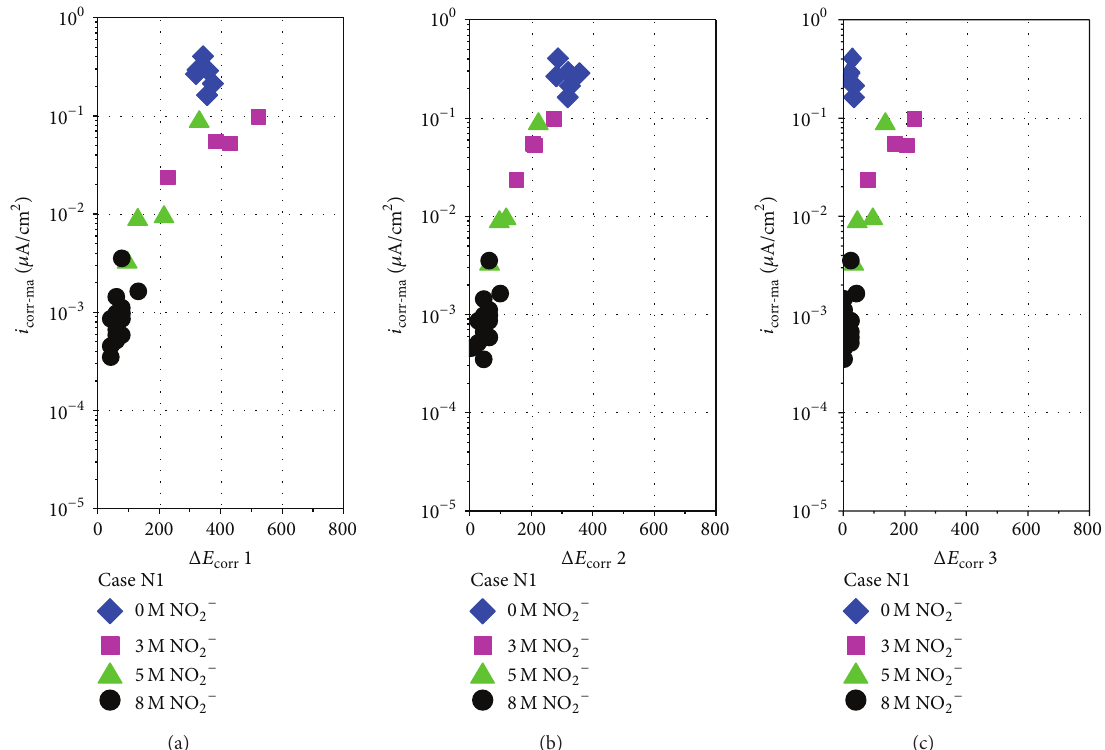
Figure 5: Effect of nitrite concentrations on the (a) relationships between Δ𝐸 Δ𝐸 2 and macrocell current density, and (c) relationships between Δ𝐸 corr